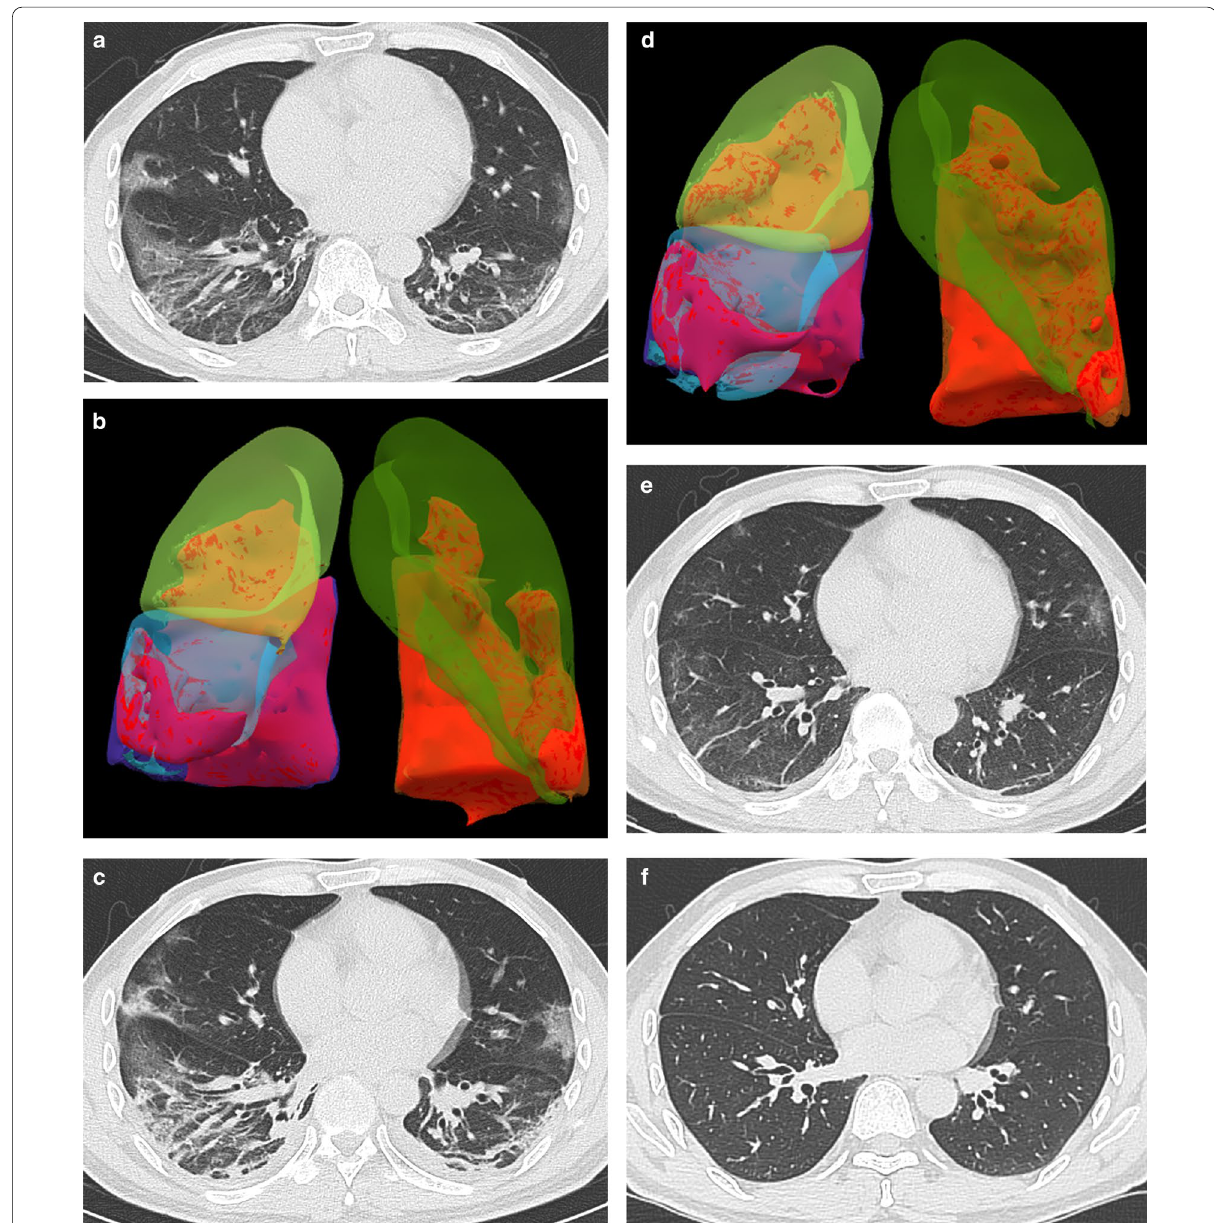
Fig. 4 Male, 45‑year‑old, COVID‑19. a Axial CT and ( b ) Volume Render (VR) Imaging. The initial CT and VR imaging obtained 7 days from onset of symptoms. The CT shows the patchy ground‑glass opacity, crazy‑paving pattern, irregular lines, and consolidation around the subpleural area, and pleura thickening. The VR imaging shows the lesions involve the bilateral lungs. c Axial CT and ( d ) VR Imaging. The peak CT and VR imaging obtained 3 days later. The CT shows that ground‑glass opacity decrease, consolidation irregular lines, and pleural thickening increase, and bilateral pleura effusion occurred. The VR imaging shows the lesion size significantly increases. e Axial CT. The pre‑discharge CT obtained 8 days later. The CT shows ground‑glass opacity, irregular lines, and pleural thickening adhesions remain. f Axial CT. The follow‑up CT obtained 34 days later shows a normal chest